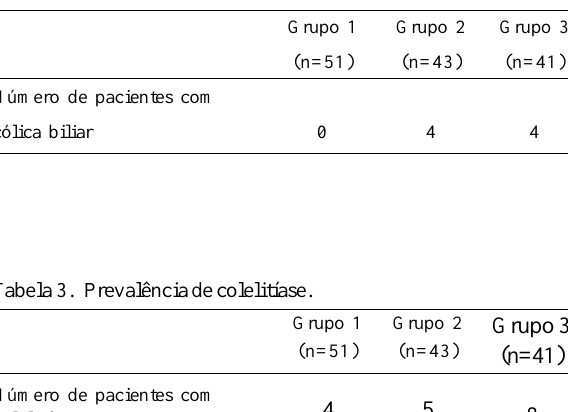
Tabela 2. Presença de cólica biliar.